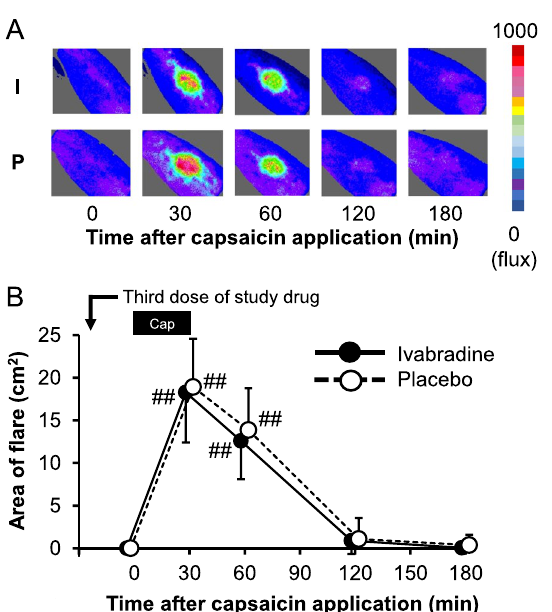
Figure 5. Effects of ivabradine and placebo on area of capsaicin-induced flare. Typical examples of laser- Doppler imaging pictures obtained from the same subject after ivabradine (I) and placebo (P) were presented in the panel ( A ). The increase in flux is indicated by a color code at the right of the panel. Panel ( B ) shows the time course of changes in flare size in both groups. Data are expressed as means ± standard deviation, with n = 20 in each group. There were no significant differences in flare size between the groups throughout the study period. Statistical significance from baseline was indicated as # p < 0.05 and ## p < 0.01. Statistical analysis was performed using two-way ANOVA with Scheffe’s multiple comparisons post-hoc test. The bar labeled as “Cap” at the top of the panel depicts the onset and duration of capsaicin